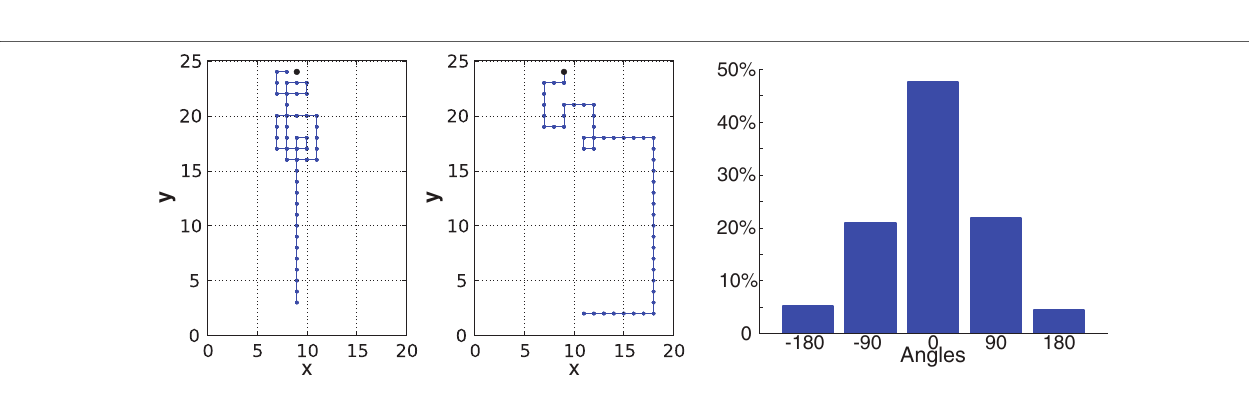
FIGURE 3 | Robot Navigation Patterns. Left: Examples of robot trajectories. The source is continuous and located at (9,24). The robot starting point is (10,2). Wind blows downwards. Right: track angle histogram. Track angles were computed as movement vectors with respect to the wind direction. A peak at 0 ° indicates a tendency to move upwind, as compared to movements perpendicular to the wind direction ( ± 90 °